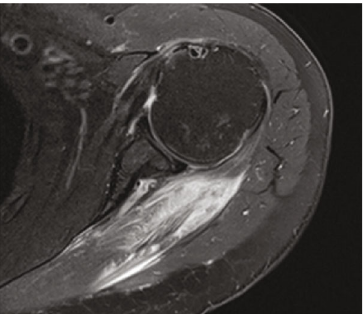
Figure 2: Axial T2 MRI of the left shoulder demonstrating hyperintensity throughout the infraspinatus muscle, consistent with